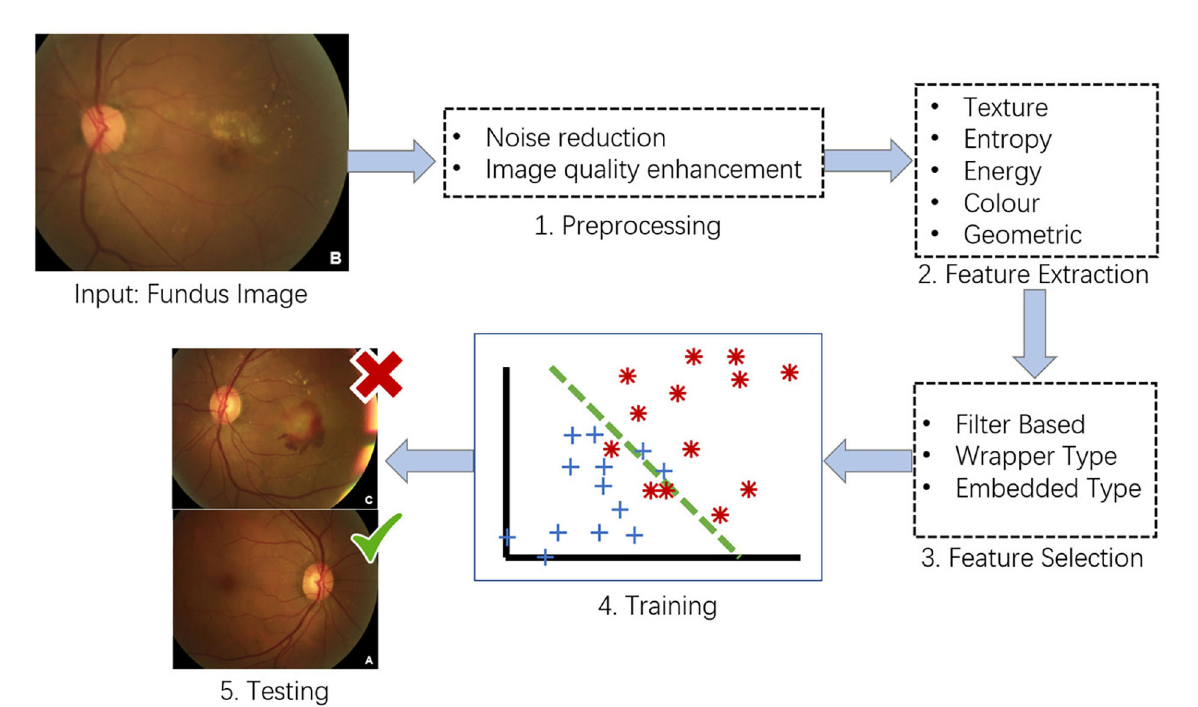
FIGURE3 Conventional framework for ARMD detection from fundus images. (1) Preprocessing – image preprocessing is performed on the input fundus image to reduce noise and enhance image quality. (2) Feature Extraction – image features such as texture, entropy and color features will be extracted from the preprocessed images. (3) Feature Selection – feature selection will be conducted on the extracted image features to select the best representative features of an image. (4) Training – at the training phase, a model such as support vector machine (SVM) will be built that tries to separate the training data into different categories e.g., ARMD and non-ARMD. (5) Testing – testing phase will apply the trained model to unseen fundus images and classify them to the known categories e.g., ARMD and